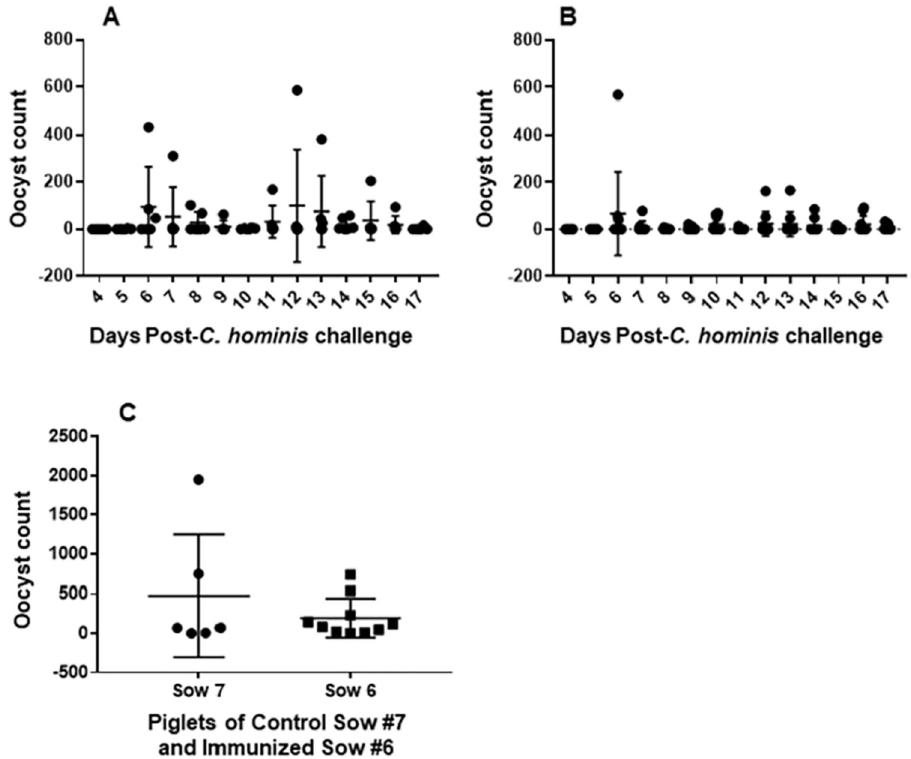
Fig 3. Daily oocyst excretion pattern following infection of the piglets with Cryptosporidium hominis . (A) piglets of the control sow #7, and (B) immunized sow #6. (C) total oocyst excretion of each piglet of control and immunized sows over 17 days